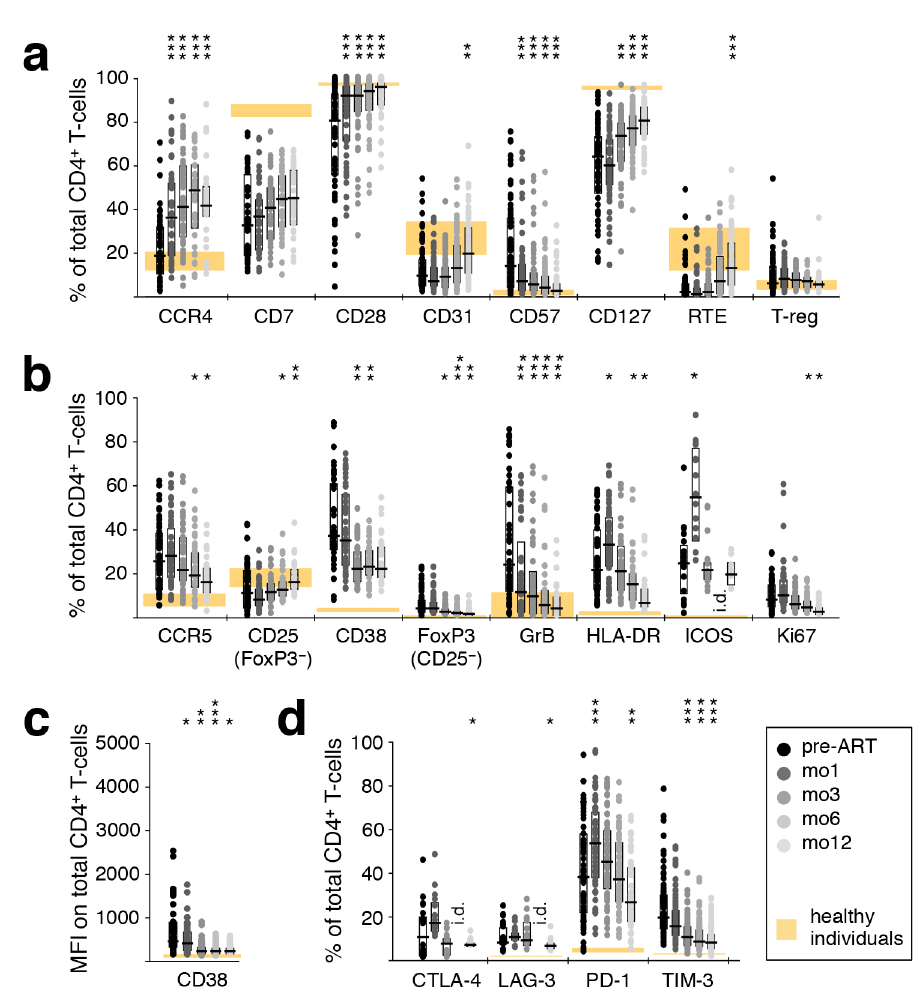
Figure 3. Reversal of CD4 + and T-cell activation during ART. Phenotypic characteristics of CD4 + T cells were analyzed by polychromatic flow cytometry in PBMC sampled before ART, as well as after 1, 3, 6, and 12 months of ART. (A) T-cell differentiation and subtypes; RTE–recent thymic emigrants. (B) Markers of activation; GrB–Granzyme B. (C) Mean fluorescence intensity of CD38. (D) Inhibitory receptors. Graphs show interquartile ranges, median bars, as well as individual data points. Orange areas represent the inter- quartile ranges of corresponding measurements in healthy individuals. All time-points were compared to corresponding pre-ART measurements: * P < 0 .01, ** P < 0 .001, *** P < 0 .0001. i.d.–insufficient data.